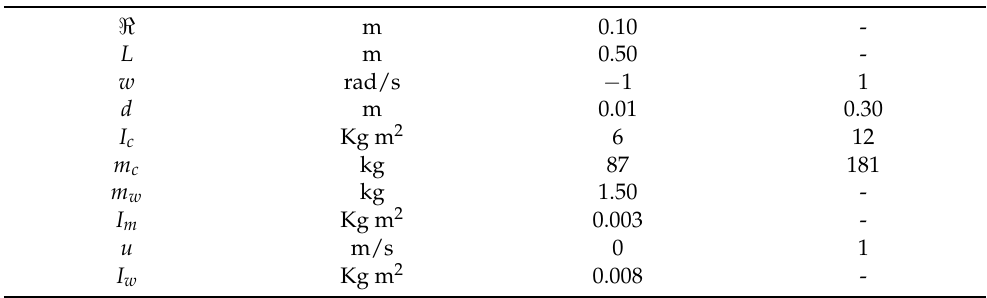
Table 1. Simulation conditions.